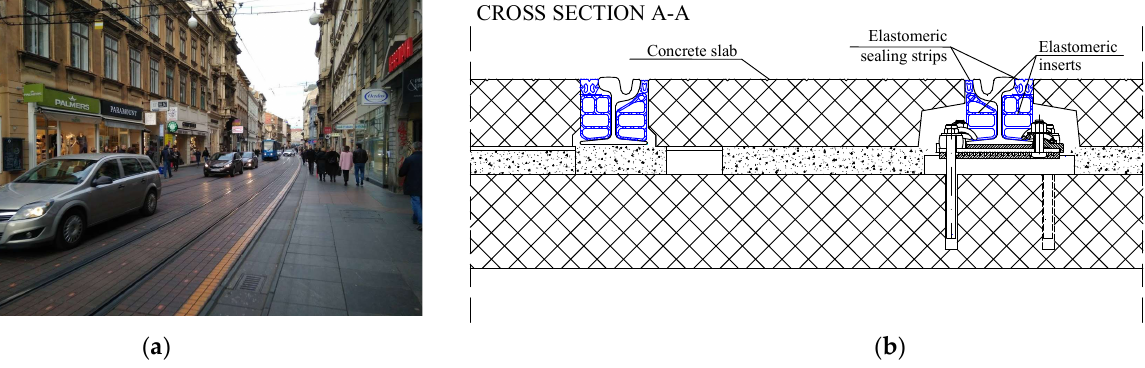
Figure 4. ( a ) Paved tram track structure in Zagreb, Croatia, built as part of the road surface cross section, as shown in ( b ).